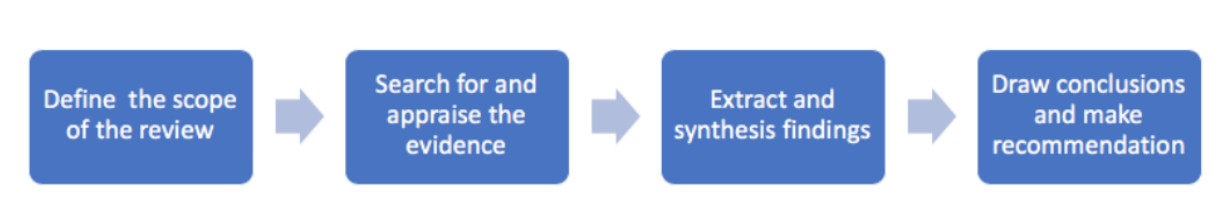
Figure 1. Review